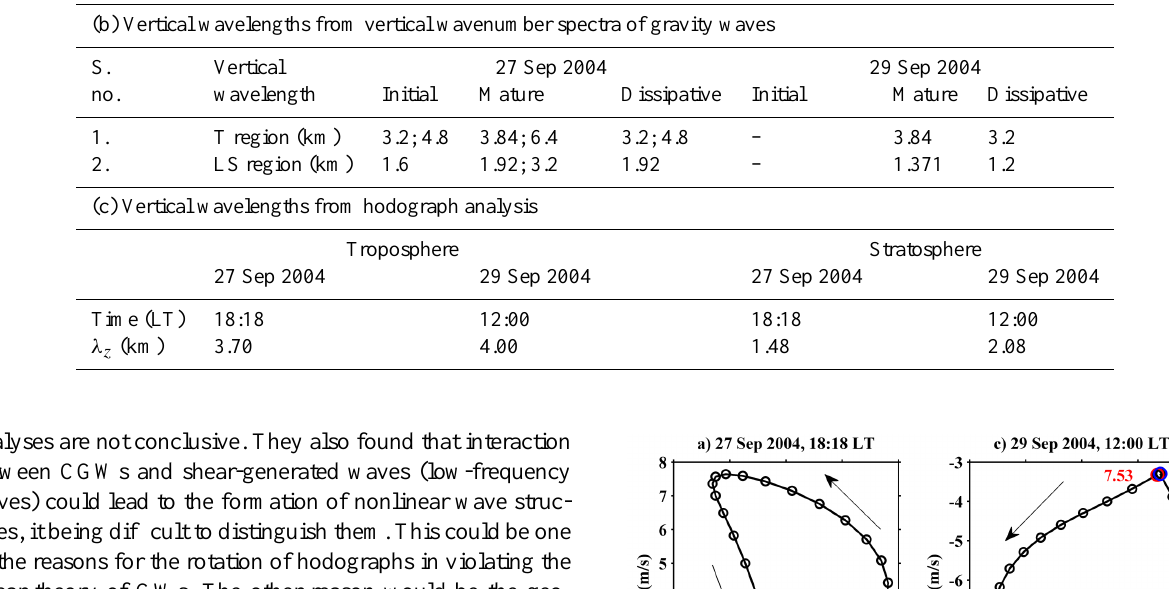
Table 1. (b) Vertical wavelengths estimated using hodograph analysis and (c) significant gravity wave periodicities noticed from the wavelet amplitude spectrum of perturbation of vertical wind velocity from MST radar in the middle troposphere (MT), upper troposphere (UT) and lower stratospheric (LS) regions during the thunderstorm and squall line passage over Gadanki.